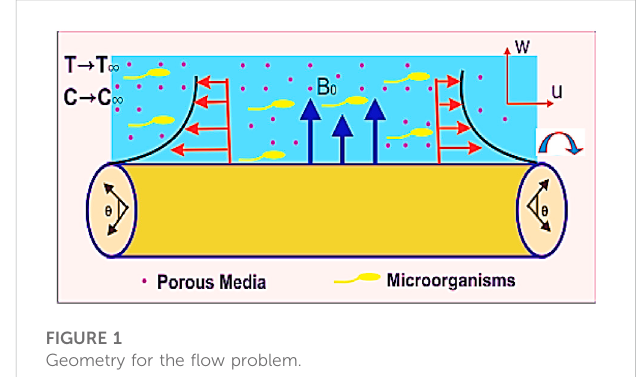
FIGURE 1 Geometry for the fl ow